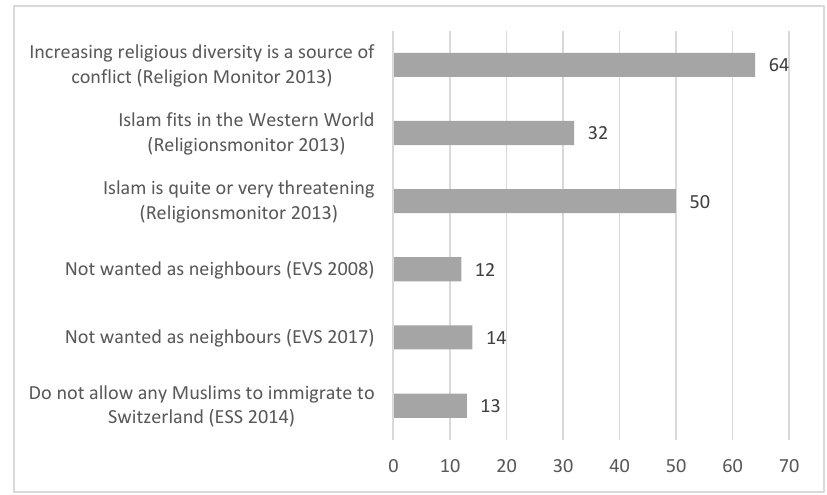
Figure 1. Source: Bertelsmann Religion Monitor (2013); European Values Study (EVS 2008, 2017); own calculations, European Social Survey (2014).